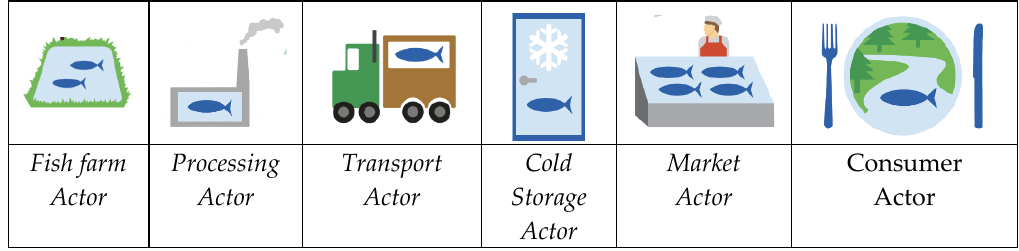
Figure 2. Farmed fish end-to-end supply chain actors.